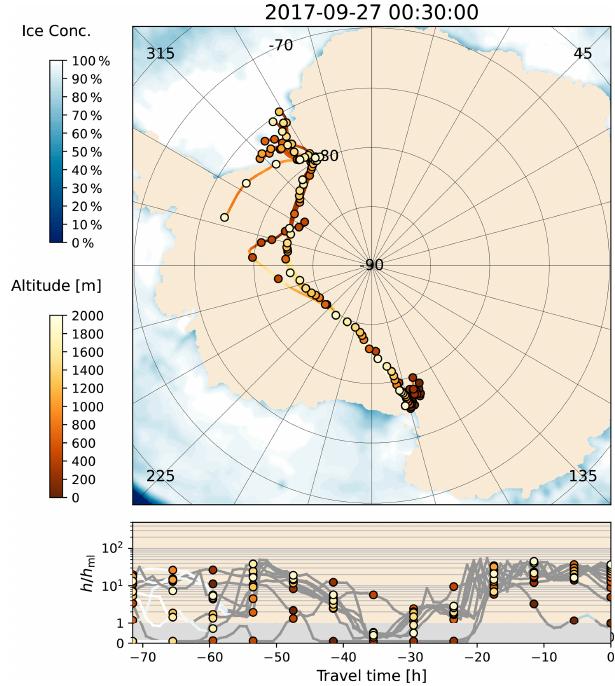
Figure 18. The 3d back trajectories ending at AH on 27 Septem- ber 2017 at 00:30UTC. Trajectories are shown for every second profile layer only. For further information, see the caption of Fig.